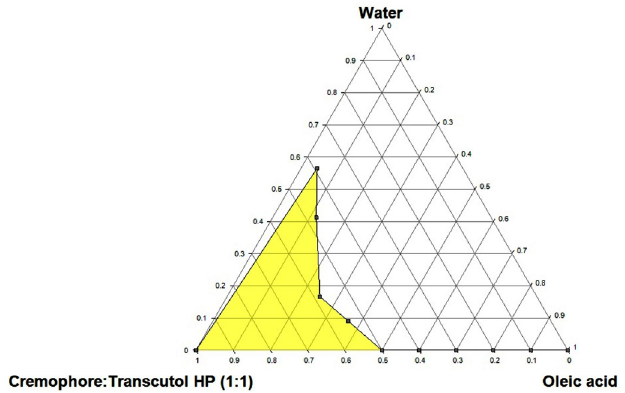
FIGURE 1 - Pseudo-ternary phase diagrams of Cremophor EL as surfactant in 1:1 ratio with Transcutol HP.